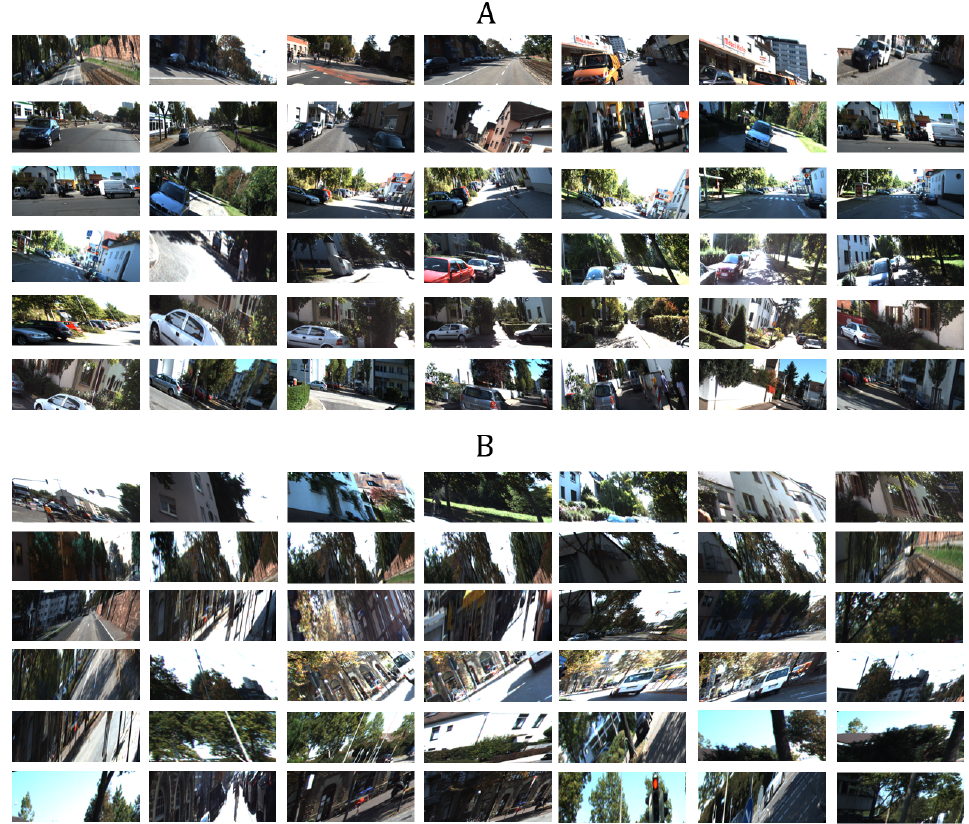
Figure A3. Preview of the dKITTI dataset. ( A ): Some examples of distorted images used for training. ( B ): Some examples of discarded images. Generated distorted images are discarded and regenerated if most of the content from the original image is lost. See Section 4 for